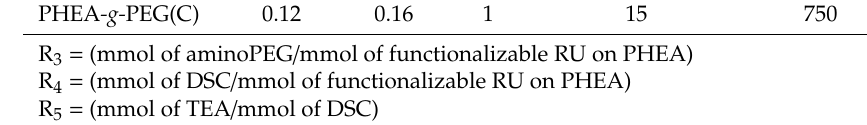
PEG Solution PEG (mL)